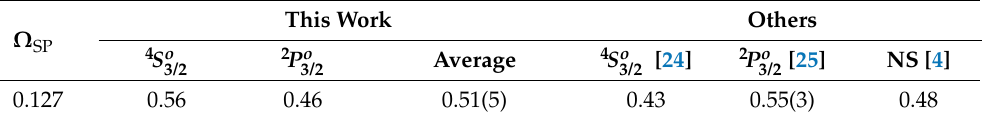
Table 2. Nuclear octupole moments of 209 Bi in µ N × b units. Ω SP was obtained with Equation